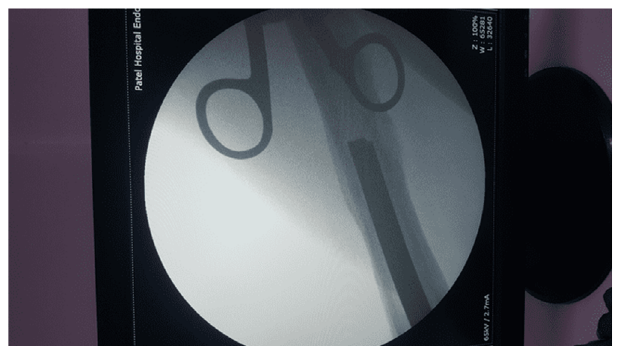
Figure 2. Proximal portion of the nail removed with distal broken portion of nail remains in situ.